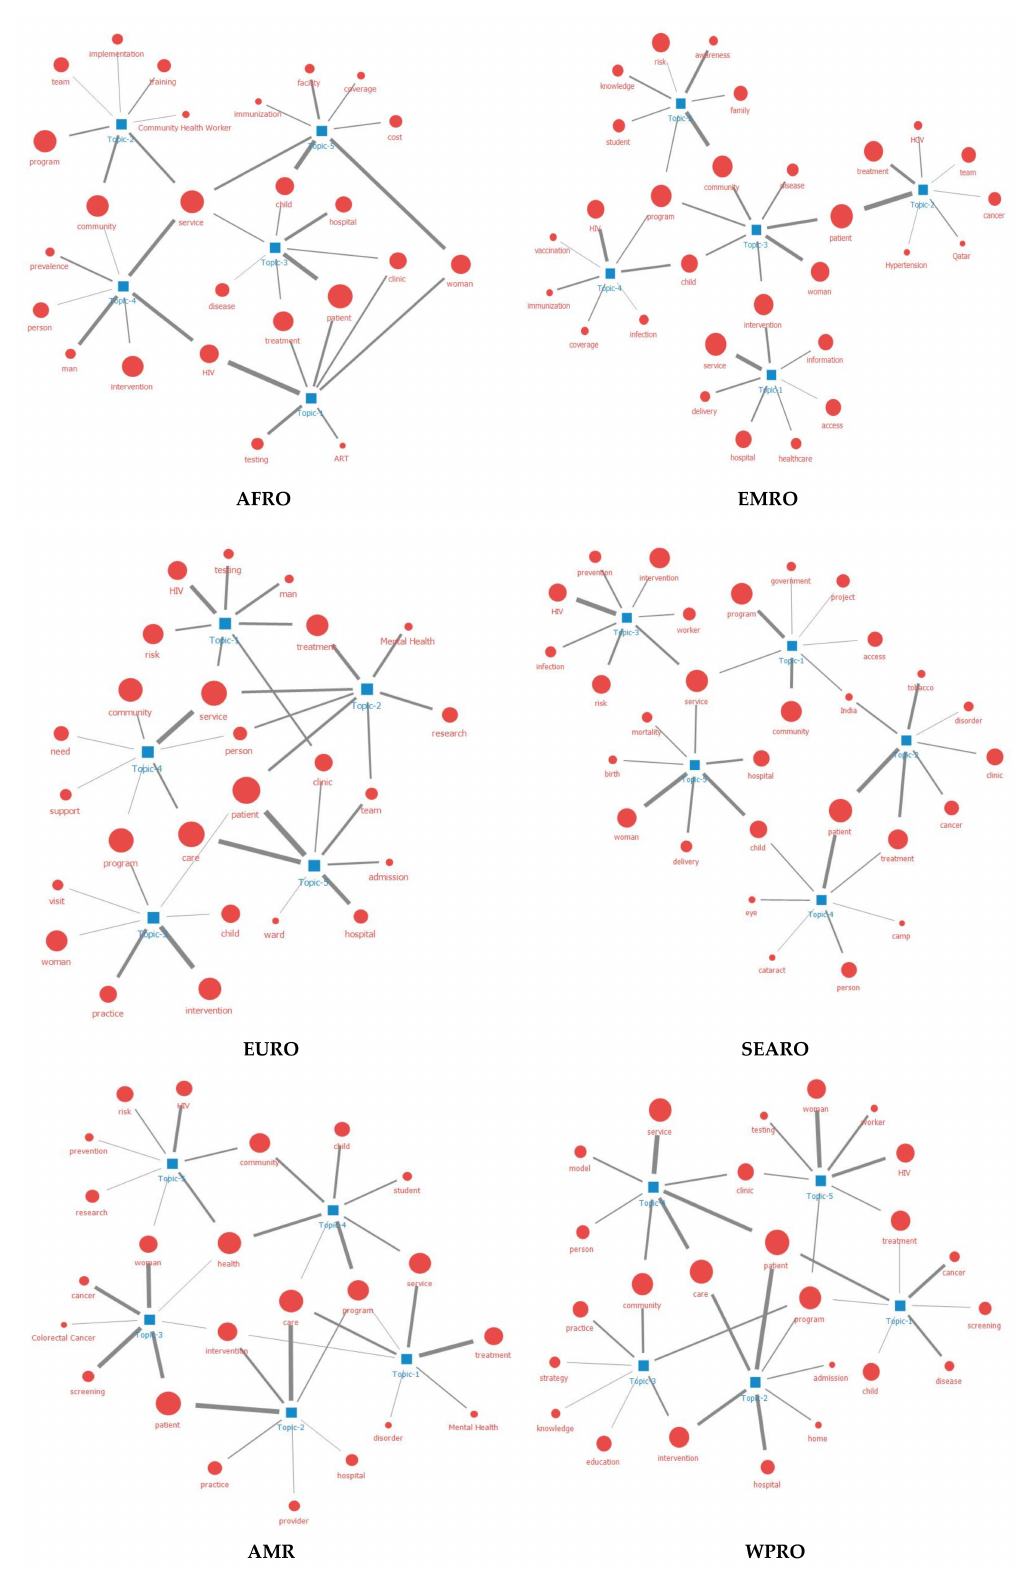
Figure 4. Topic modeling of outreach research by each region. The size of the node indicates the degree centrality of the keyword, and the width of the line indicates the strength of the link between keywords; AFRO = African Region; AMR = Re- gion of the Americas, SEARO = South-East Asia Region; EURO = European Region; EMRO = Eastern Mediterranean Region; WPRO = Western Pacific